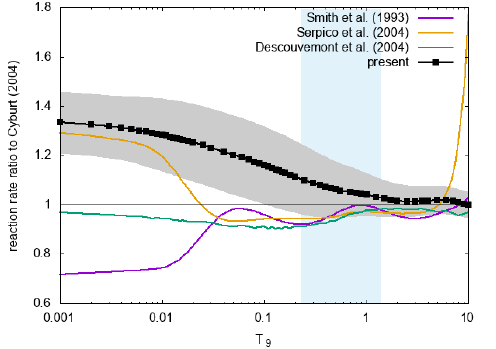
Figure 7. Reaction rates of the 7 Be(n, p) 7 Li normalized to that of Cyburt et al. [1]. The n_TOF data are shown with the associated error band (cid:39) 10%. Previously calculated rates are also shown in the figure. The temperature range of BBN with a larger impact on the lithium yield is indicated by the vertical band. Reprinted figure with permission from: Damone et al. (The n_TOF Collaboration), Phys. Rev. Lett. 121, 042701—2018. Copyright (2018) by the American Physical